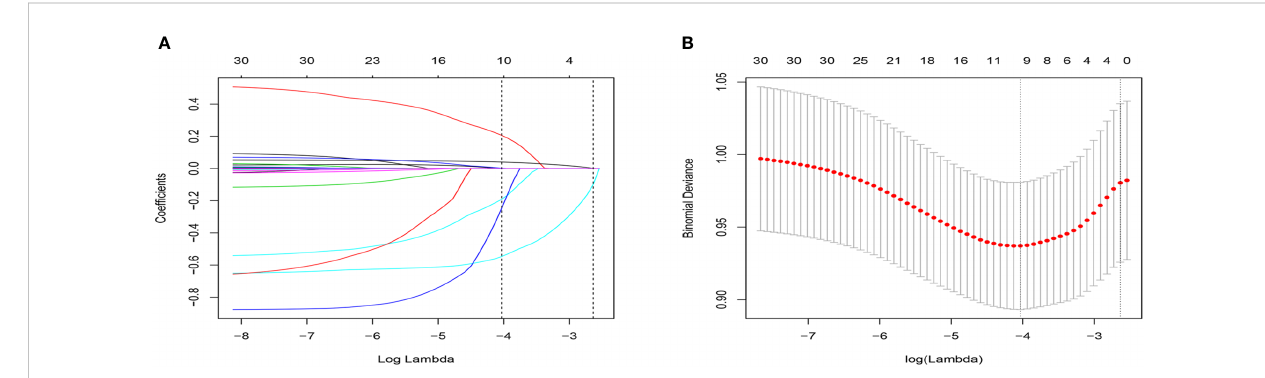
FIGURE 2 Selection of variables using the LASSO regression model. (A) The coef fi cient pro fi le was plotted against the log (lambda) sequence. (B) The plot of partial likelihood deviance (binomial deviance) versus log (lambda) was